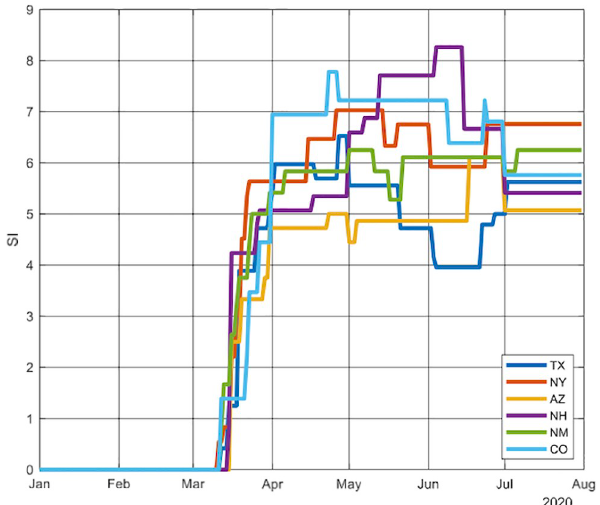
Fig 2. Path of mitigation measures (Bentley Stringency Index) over time in each state. Legend : A comparison of the degree of stringency of mitigation measures by each state shows that though the states all responded by introducing mitigation measures, there are substantial variations between